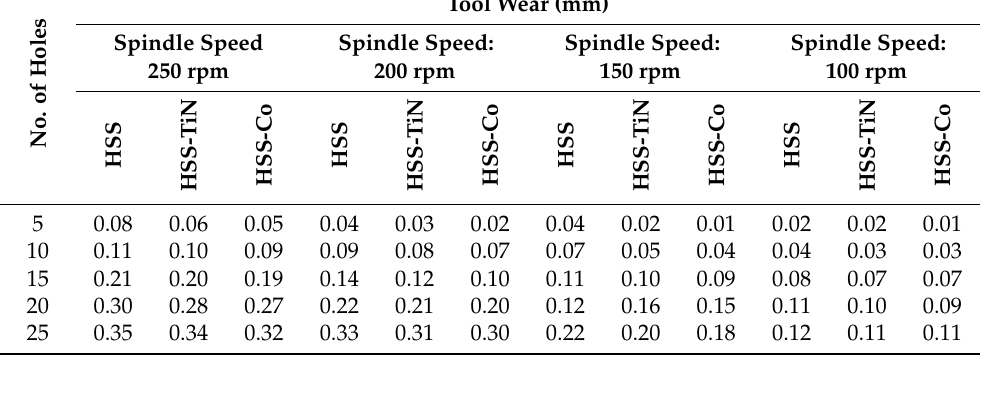
H o f o f o . o . N N